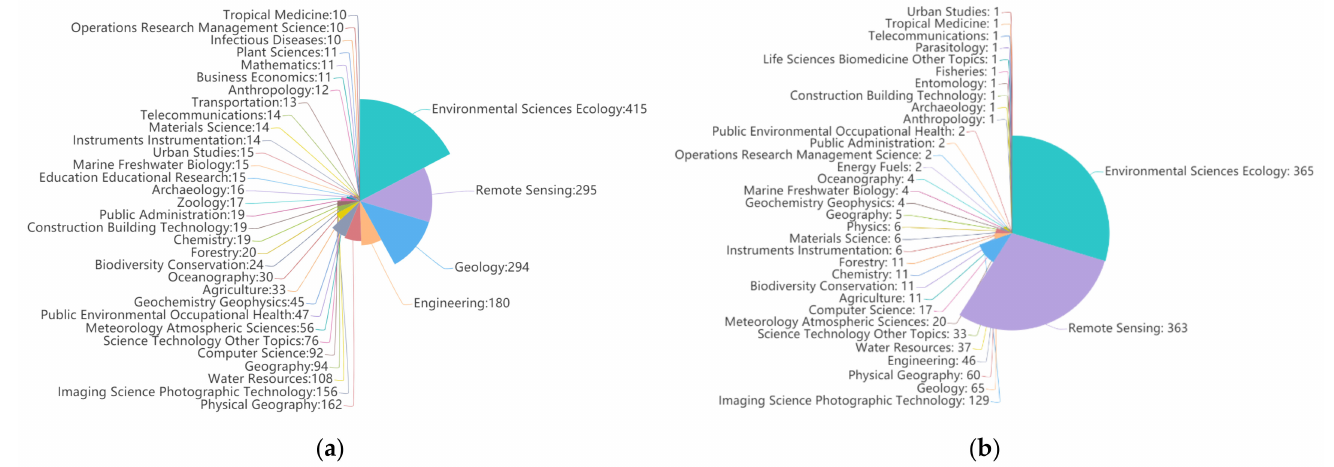
Figure 3. Research disciplines in which ( a ) GE and ( b ) GEE were